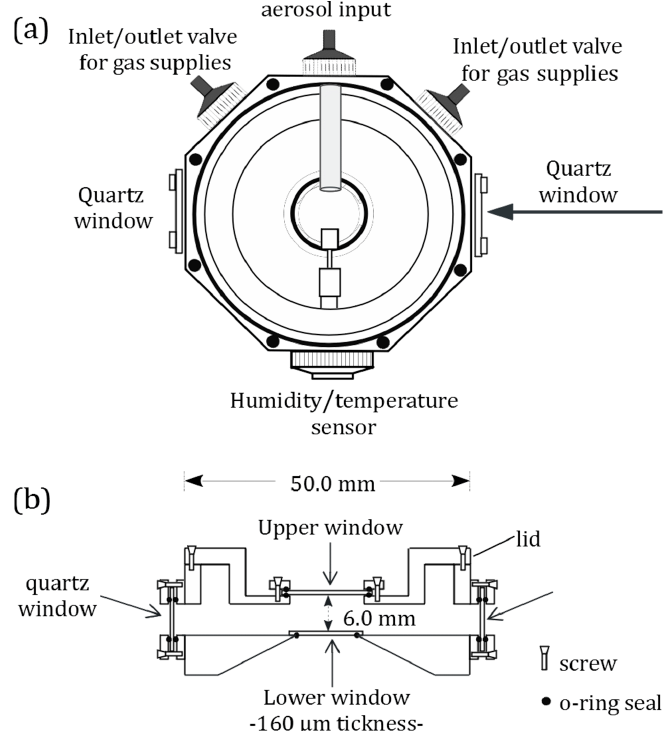
Figure 3. ( a ) Top (without lid) and ( b ) cross-section views of the levitation chamber used for